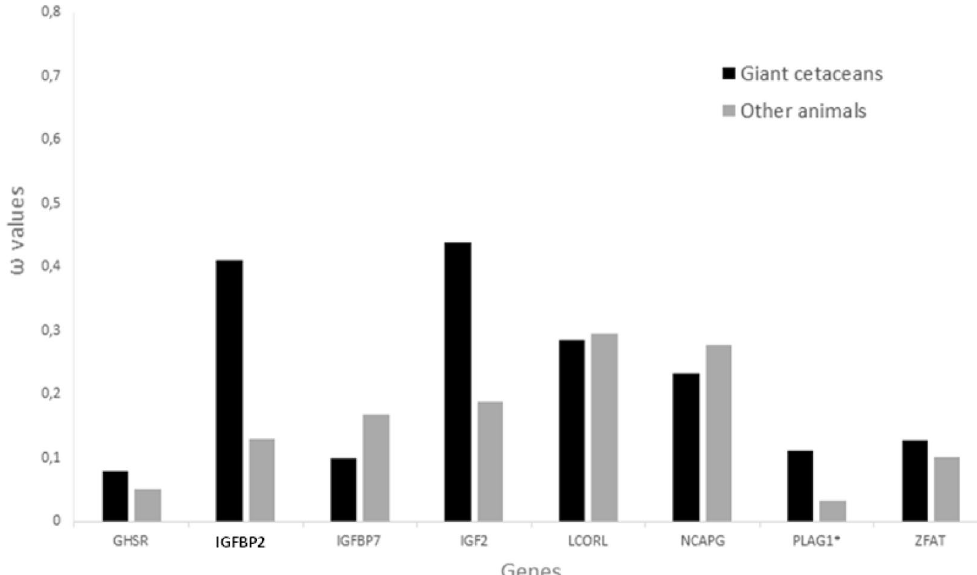
Figure 2. Comparison of ω values calculated using the two-ratio model in codeML for genes related to body size in giant cetaceans and other mammals. The two-model was better suited to the data (p < 0.05) in the PLAG1 gene, marked with an asterisk. The IGFBP2 gene, in bold, represents the statistically significant intensified selection that the RELAX program detected ( p < 0.05) in giant cetaceans.